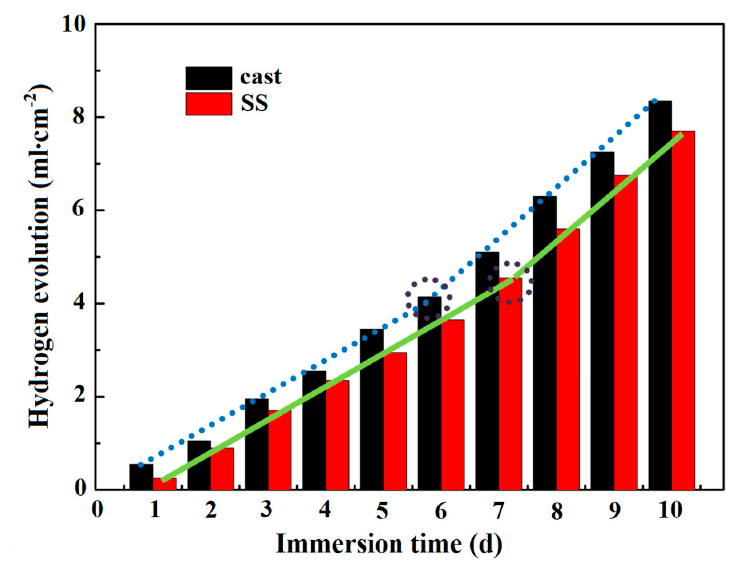
Figure 7. Potentio-dynamic polarization (PDP) curves and related parameters of the Mg-9Li alloys tested at different exposure time. ( a ) and ( c ) are the pdp curves and the evolution of E corr and I corr values of the cast alloy. ( b ) and ( d ) are the pdp curves and the evolution of E corr and I corr values of the cast alloy.